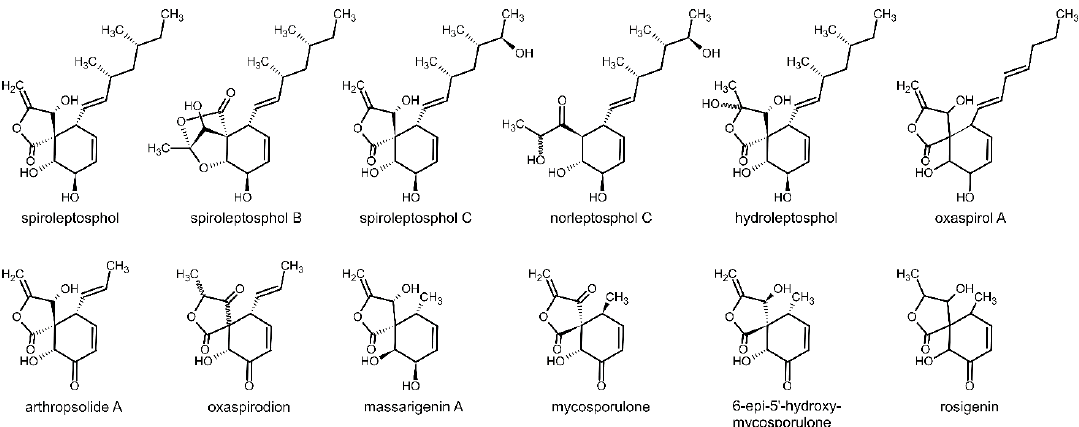
Figure 1. Spiroleptosphols and analogous compounds known from literature.